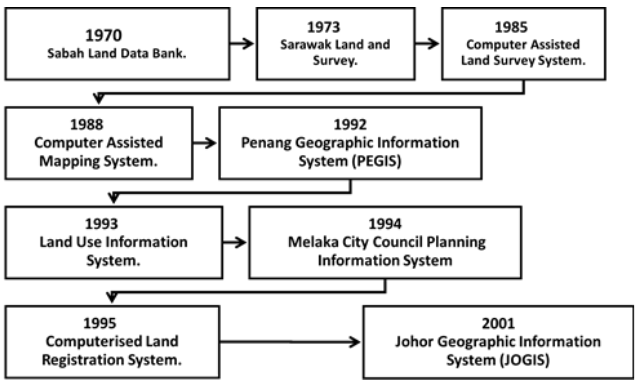
Figure 2. Various geospatial digitised systems in Malaysia before the 21st century.